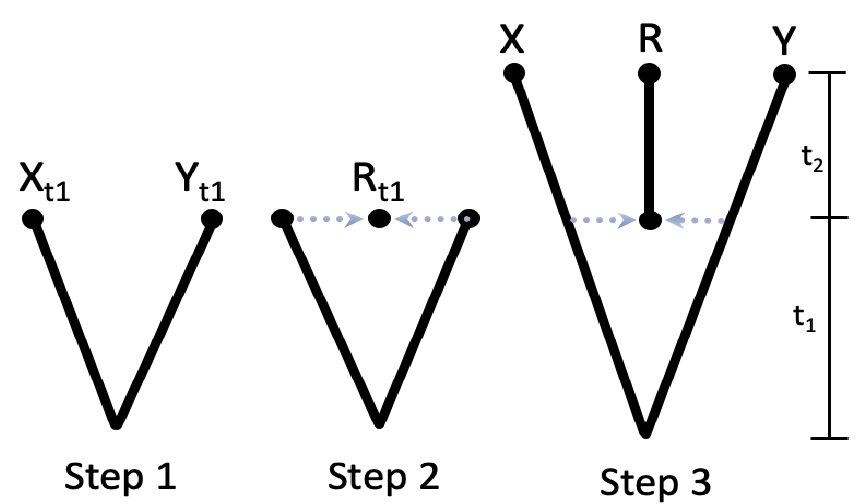
Figure 2. Evolution scenario for 3-taxa phylogenetic network containing a reticular hybridiza- tion